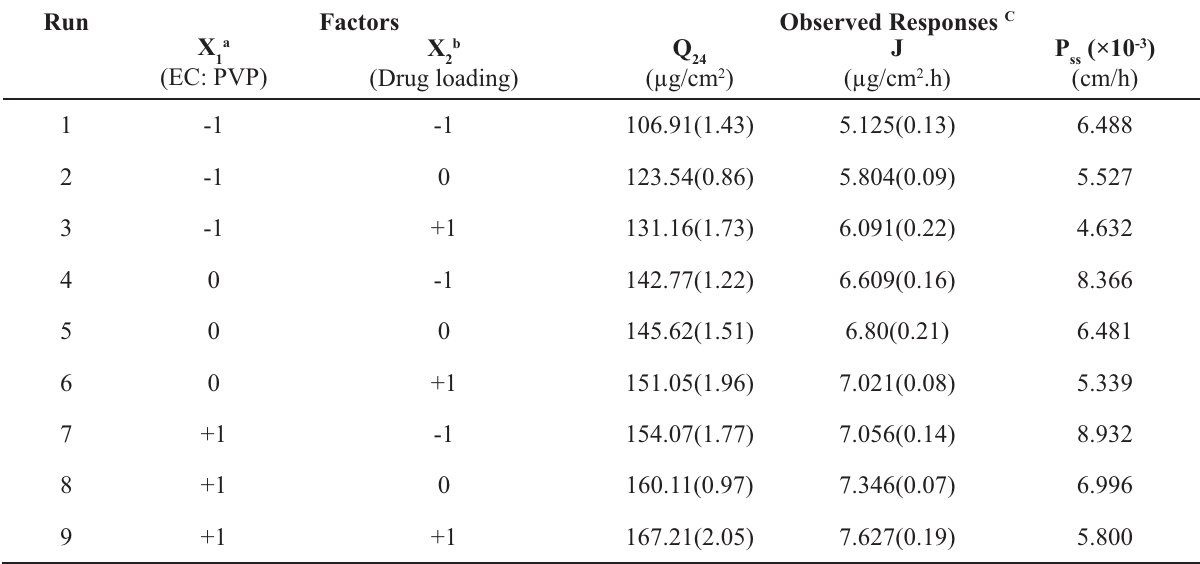
Table 1 – Composition and observed responses from randomized runs in 3 2 full factorial design. Run Factors Observed Responses